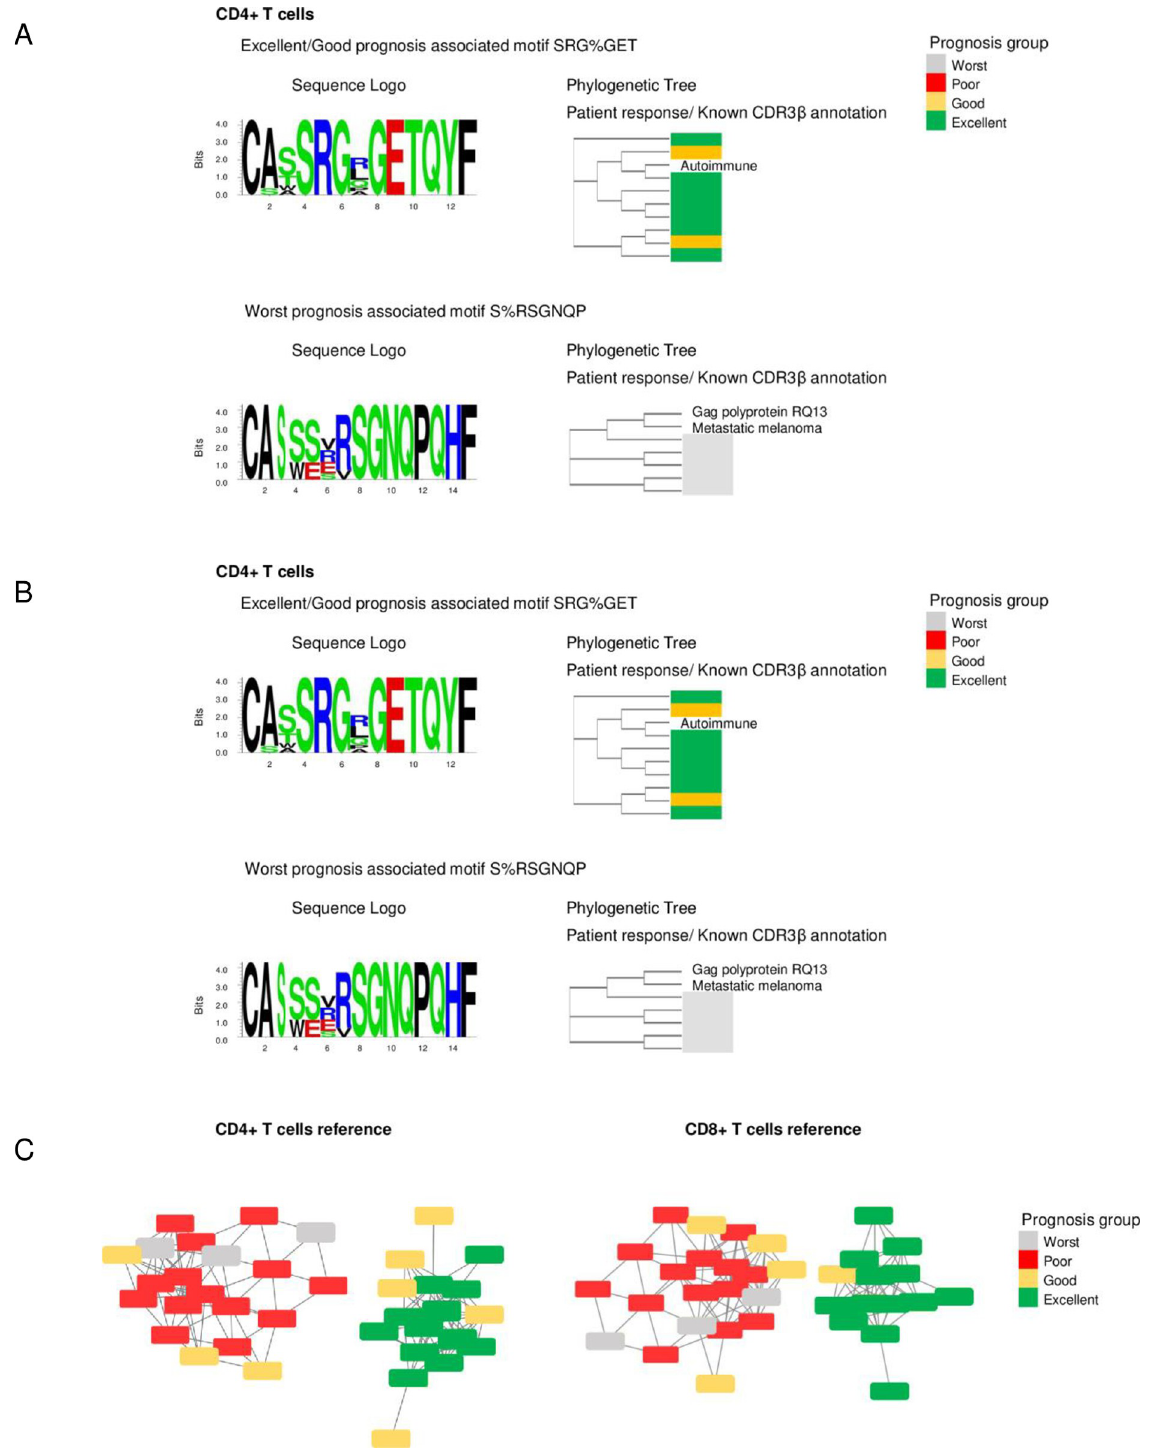
Fig 4. Ascitic fluid cell CDR3 β motifs associated with prognosis. (A) Examples of CD4+ T cell receptor (TCR) motifs associated with different prognoses. (B) Examples of CD8+ TCR motifs associated with different prognoses. The figures show the logo and phylogenetic tree of the clustered CDR3 β peptides for each motif. The phylogenetic tree also includes peptides found as the best hit from McPAS; the complete set of motifs associated with excellent or poor/worst prognosis is shown in S7A Table. (C) Association networks constructed to form the cluster of motifs associated with response to platinum therapy. Nodes in the networks indicate individual patients; the color of the node